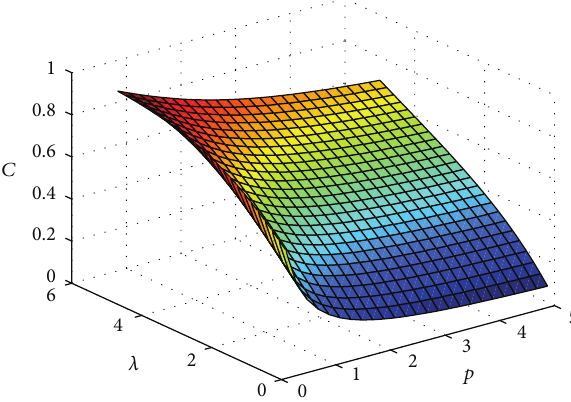
Figure 7: Effects of 𝜆 and 𝑝 on concentration profile for solution given in (37). Here 𝑅 = 𝑅 𝑎 = 2